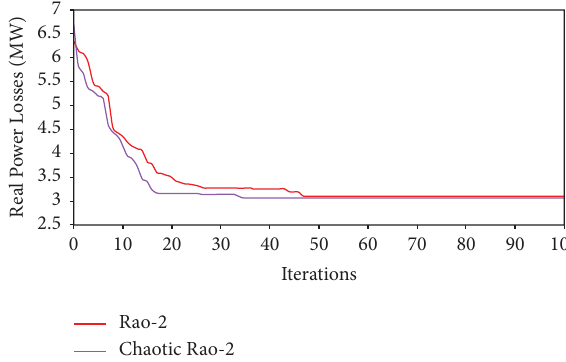
Figure 4: Convergence traits for case 2 using Rao-2 and the chaotic Rao-2 algorithms.